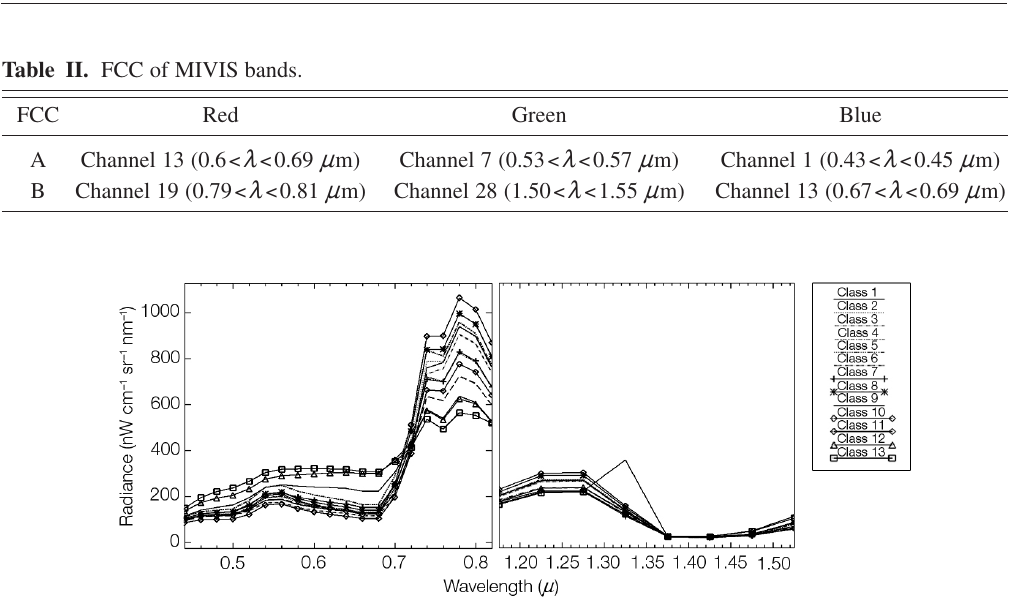
Relations between morphological settings and vegetation covers in a medium relief landscape of Central Italy